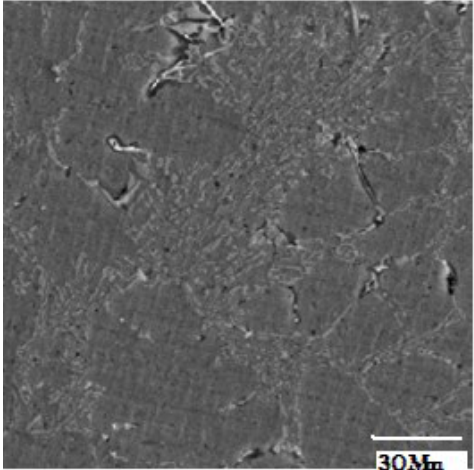
Figure 12. The microstructure of A356 reinforced with 3 weight% ZrO 2 at 270 rpm stirring speed.